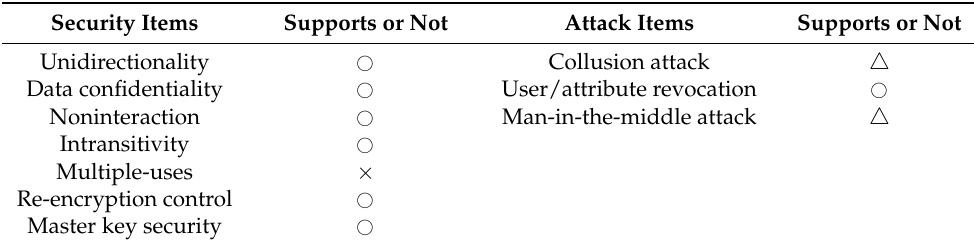
Table 3. The Security Analysis of Proposed